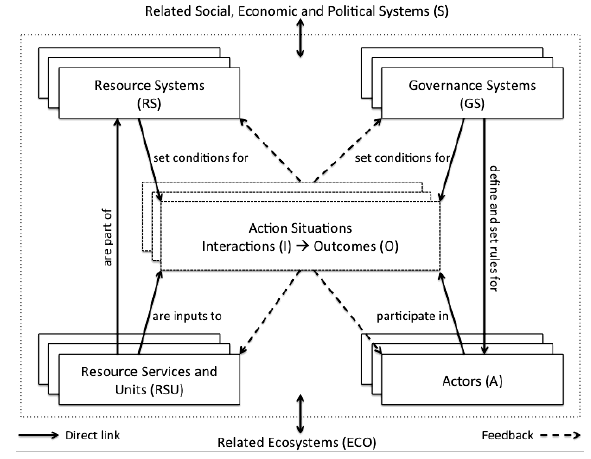
Fig. 1. Social-ecological system framework. Source: McGinnis and Ostrom